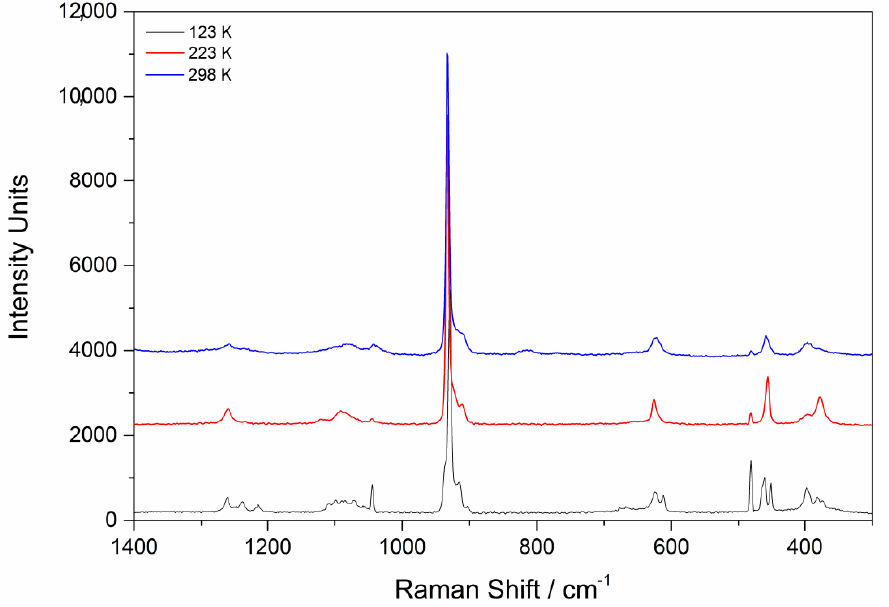
Figure 6. Raman spectra of compounds 1-O (223 and 298 K) and 1-M (123 K) in the Cl–O Raman shift range.